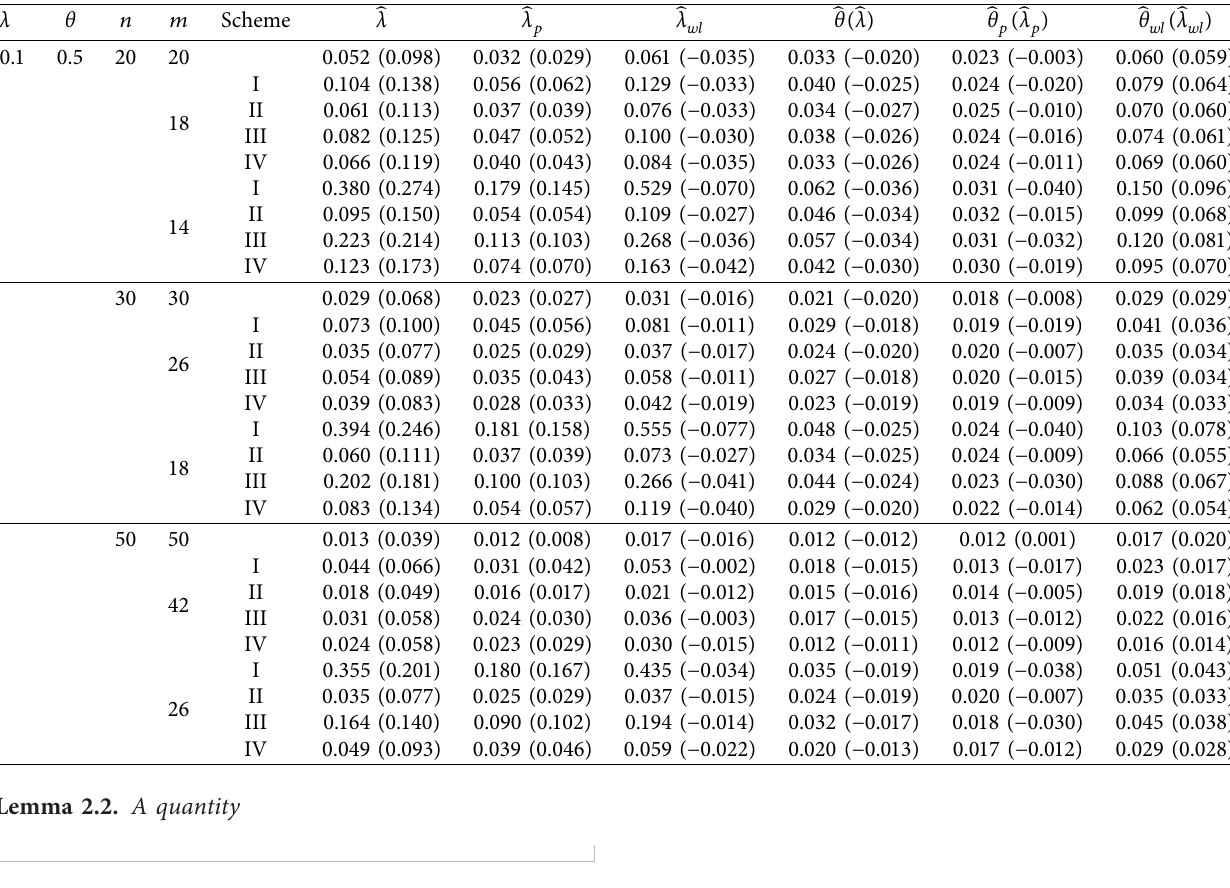
Table 1: MSEs(biases) for λ and θ